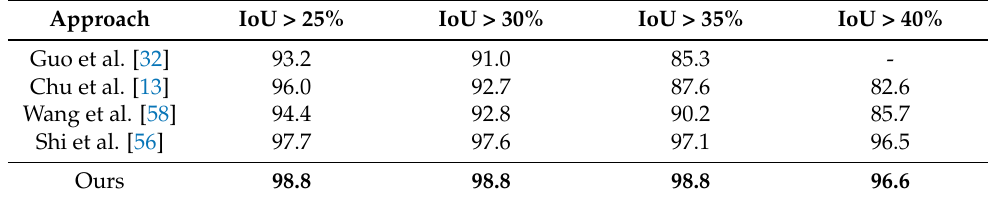
Table 4. Grasp prediction accuracy (%) for Cornell dataset at different Jaccard thresholds.